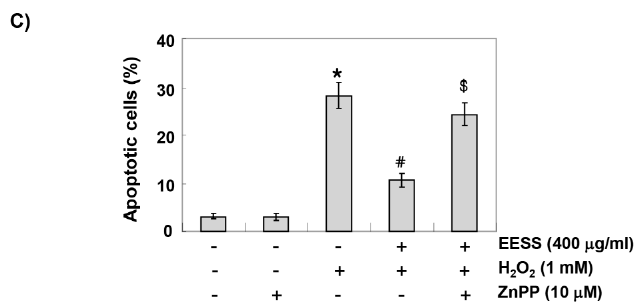
Figure 6. Effects of EESS on H 2 O 2 -induced ROS generation, DNA damage, and apoptosis in SW1353 chondrocytes. The cells were pretreated for 1 h with 400 μ g/mL EESS, and then treated for 24 h with or without 1 mM H 2 O 2 in the absence or presence of 10 μ M ZnPP. ( A ) After incubation with 10 μ M JC-1 for 20 min, JC-1 fluorescence intensity was detected by flow cytometry. Each point represents the mean of two independent experiments; ( B ) The comet assay was performed to detect cellular DNA damage, and representative photographs of the comets were taken by fluorescence microscopy (original magnification, 200×); ( C ) To quantify the degree of apoptosis, the cells were stained with FITC-conjugated Annexin-V and PI for flow cytometry analysis. The data are represented as the means ± SD obtained from three independent experiments (* p < 0.05 compared with the control group; # p < 0.05 compared with the H 2 O 2 -treated group; & p < 0.05 compared with H 2 O 2 and the EESS-treated group).